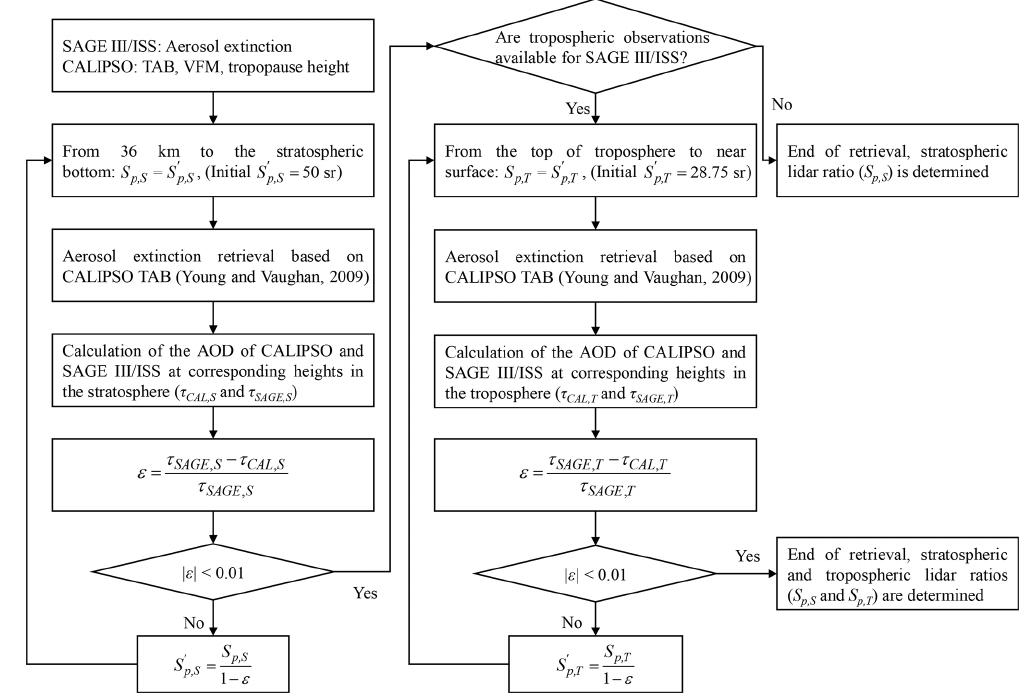
Figure 2. Flowchart for the retrieval of lidar ratio by using SAGE III/ISS AOD as a